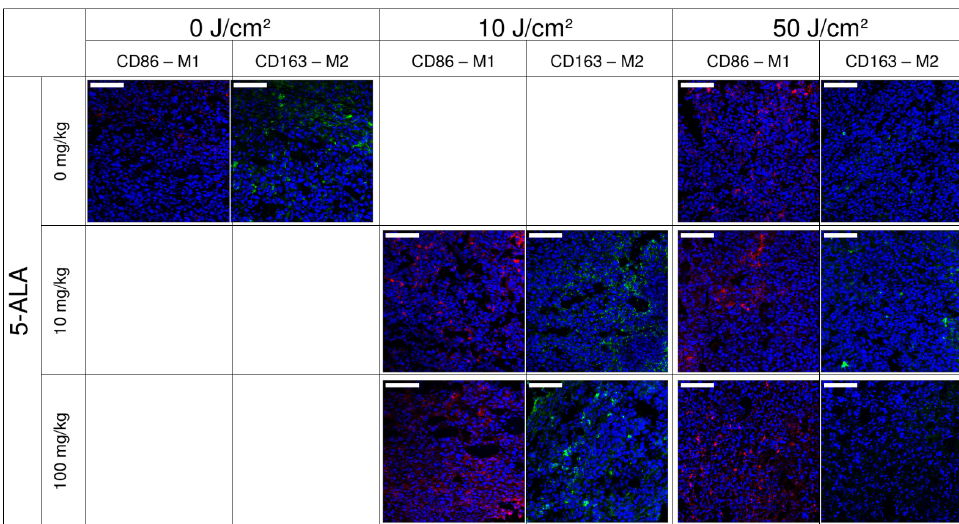
Figure 7. Staining for the presence of M1 and M2 macrophages in tumor sections after ALA–PDT (CD86+ is shown in red, CD163+ in green). Scale bars are 100 μm.